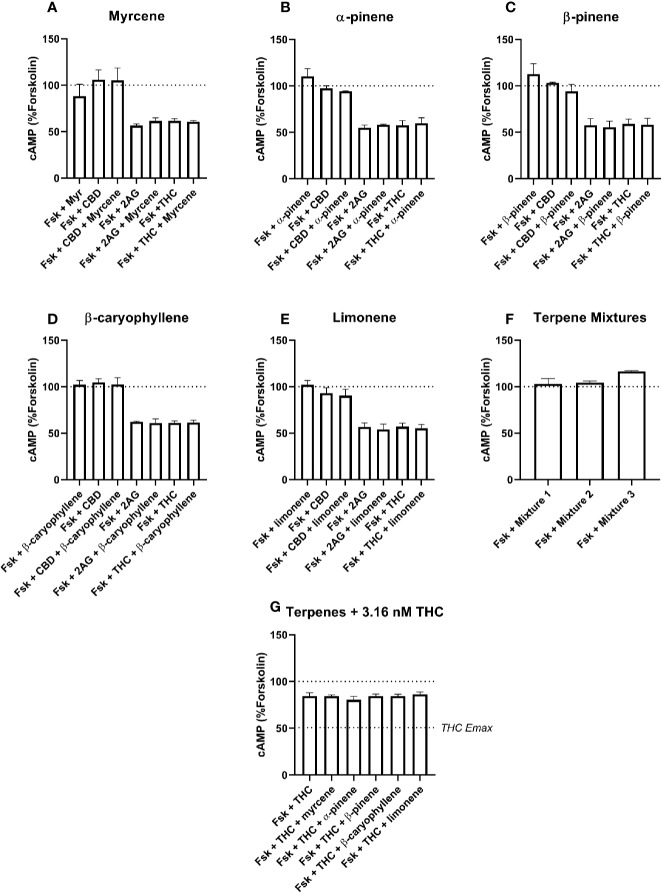
hCB1-Mediated inhibition of cAMP production in response to forskolin (Fsk) and drug combinations with 10 µM myrcene (A), α-pinene (B), β-pinene (C), β-caryophyllene (D), limonene (E), or terpene mixtures (F). Figure (G) shows inhibition of the Fsk response by an approx. EC50 concentration of THC (3.16 nM) in combination with 10 µM of each of the five terpenes. Data are normalized to forskolin (100%) and basal (0%). cAMP responses were stimulated with forskolin (5 µM), and all cannabinoids and terpenes were at a final concentration of 10 µM. Data are means ± SEM of three independent determinations.